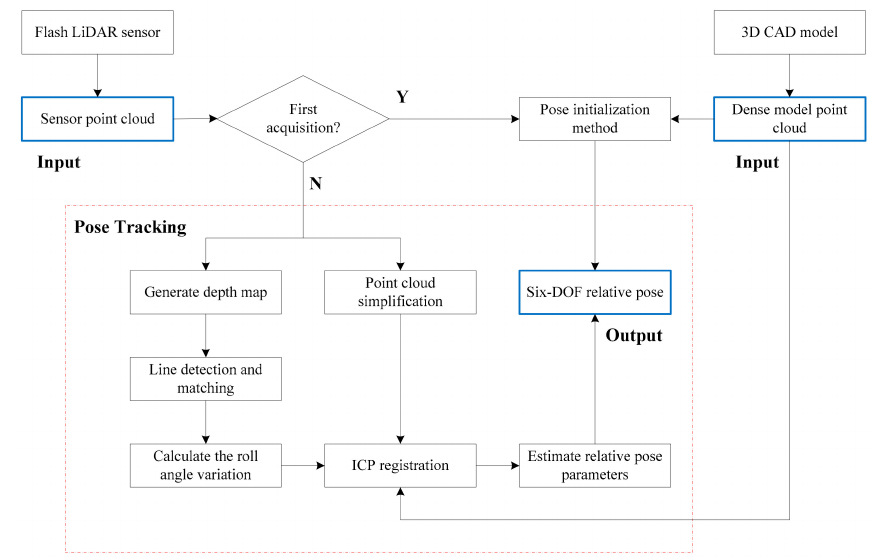
Figure 2. Framework overview.